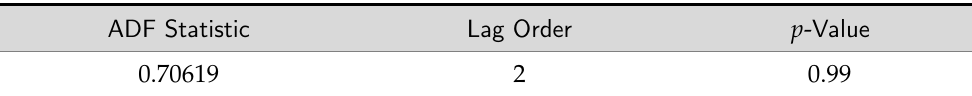
Table 1. Augmented Dickey–Fuller